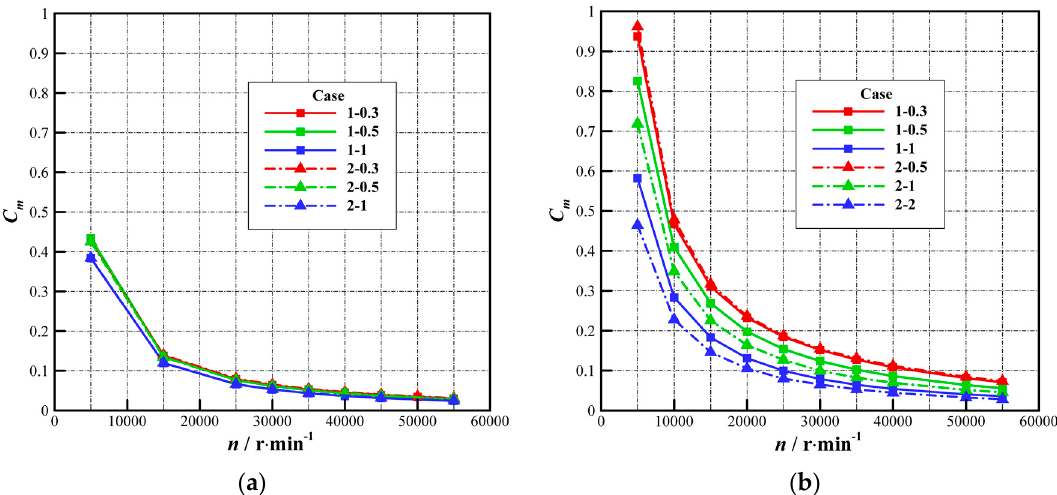
Figure 5. Flow coefficient versus rotational speed of each case for two kinds of multichannel Tesla turbines: ( a ) one-to-one Tesla turbine; and ( b ) one-to-many Tesla turbine. turbines: ( a ) one-to-one Tesla turbine; and ( b ) one-to-many Tesla turbine.